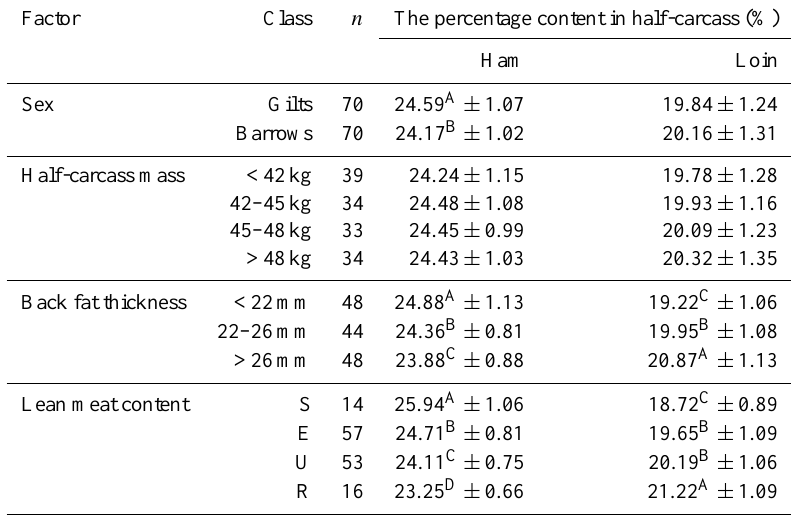
Table 1. The percentage content of ham and loin in half-carcasses according to factors tested. Factor Class n The percentage content in half-carcass (%)